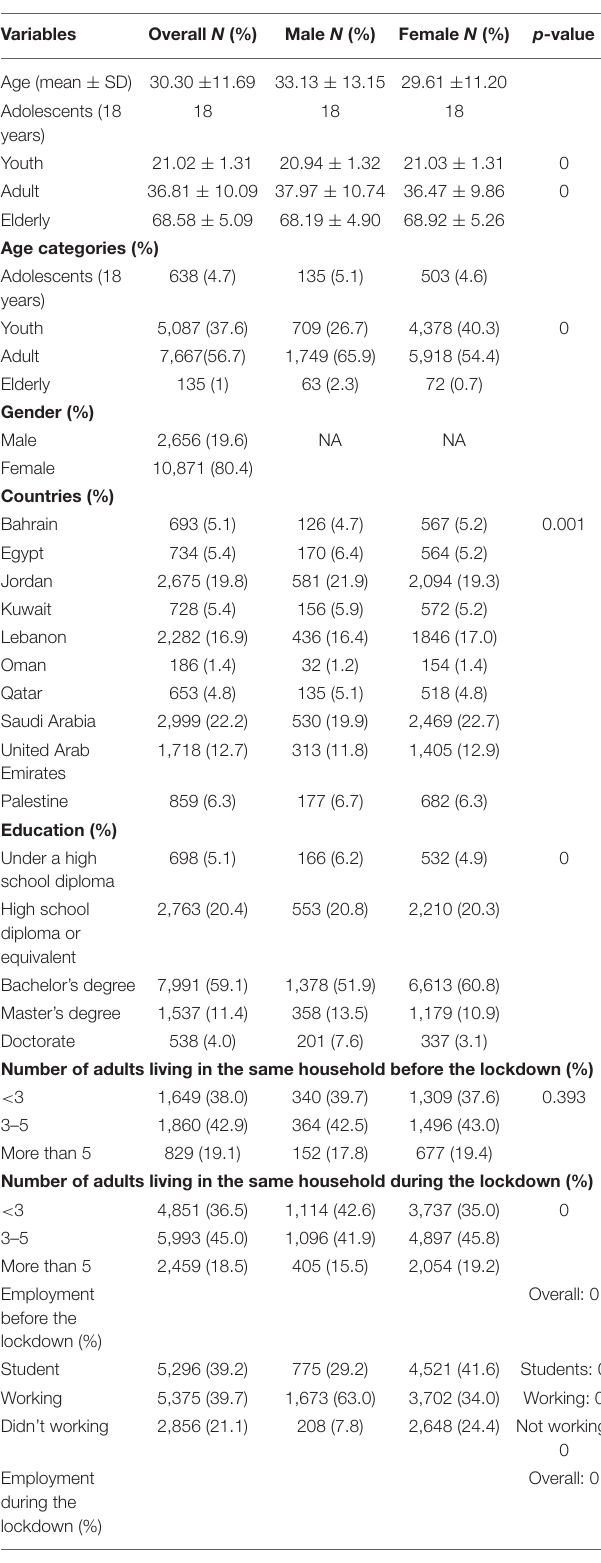
TABLE 1 | sociodemographic and socioeconomic characteristics of the studied population.